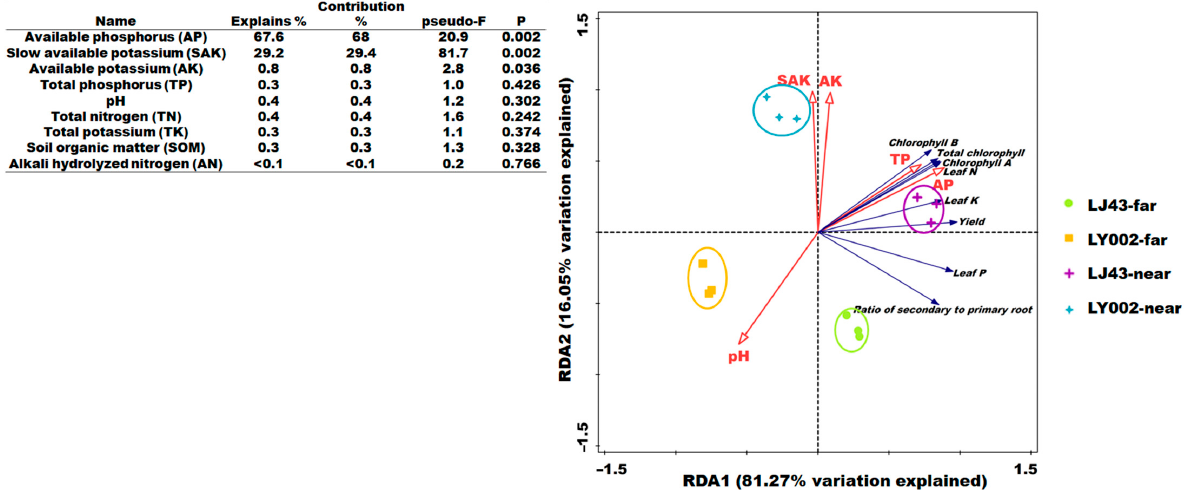
Figure 2. RDA ranking of soil nutrient and tea plant